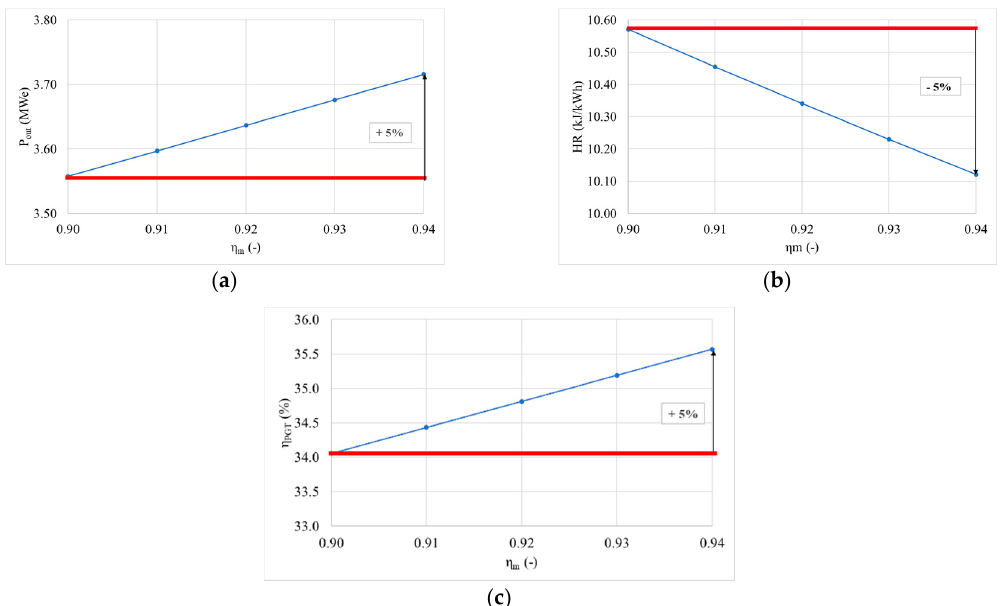
Figure 12. Change of gas turbine cycle outlet parameters in function of mechanical efficiency ( a ) power change in function of mechanical efficiency, ( b ) heat rate change in function of mechanical efficiency and ( c ) gas turbine plant efficiency change in function of mechanical efficiency.